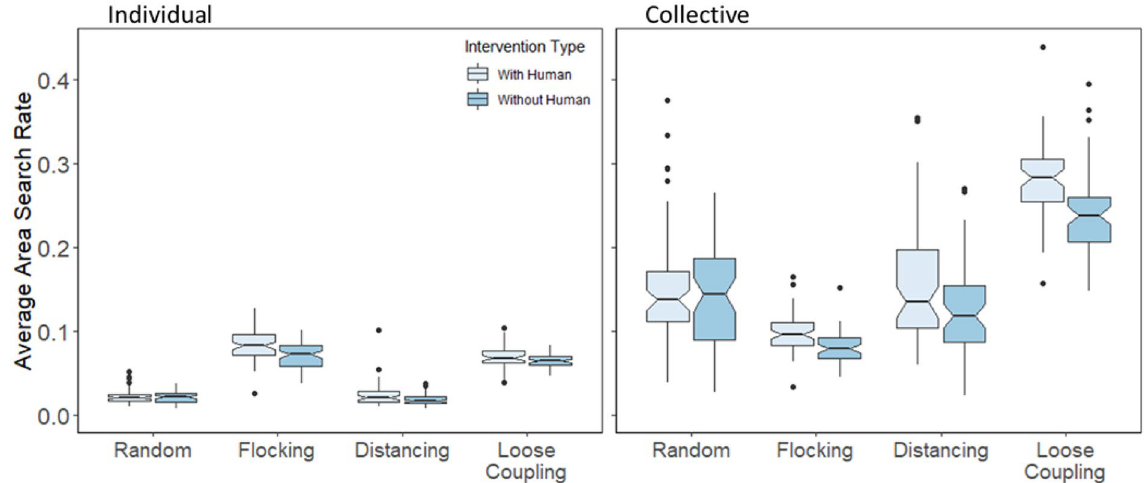
Figure 9. Area search rate for autonomous agents, averaged for each session, and plotted as a function of movement type and human intervention for agents individually (left) and collectively